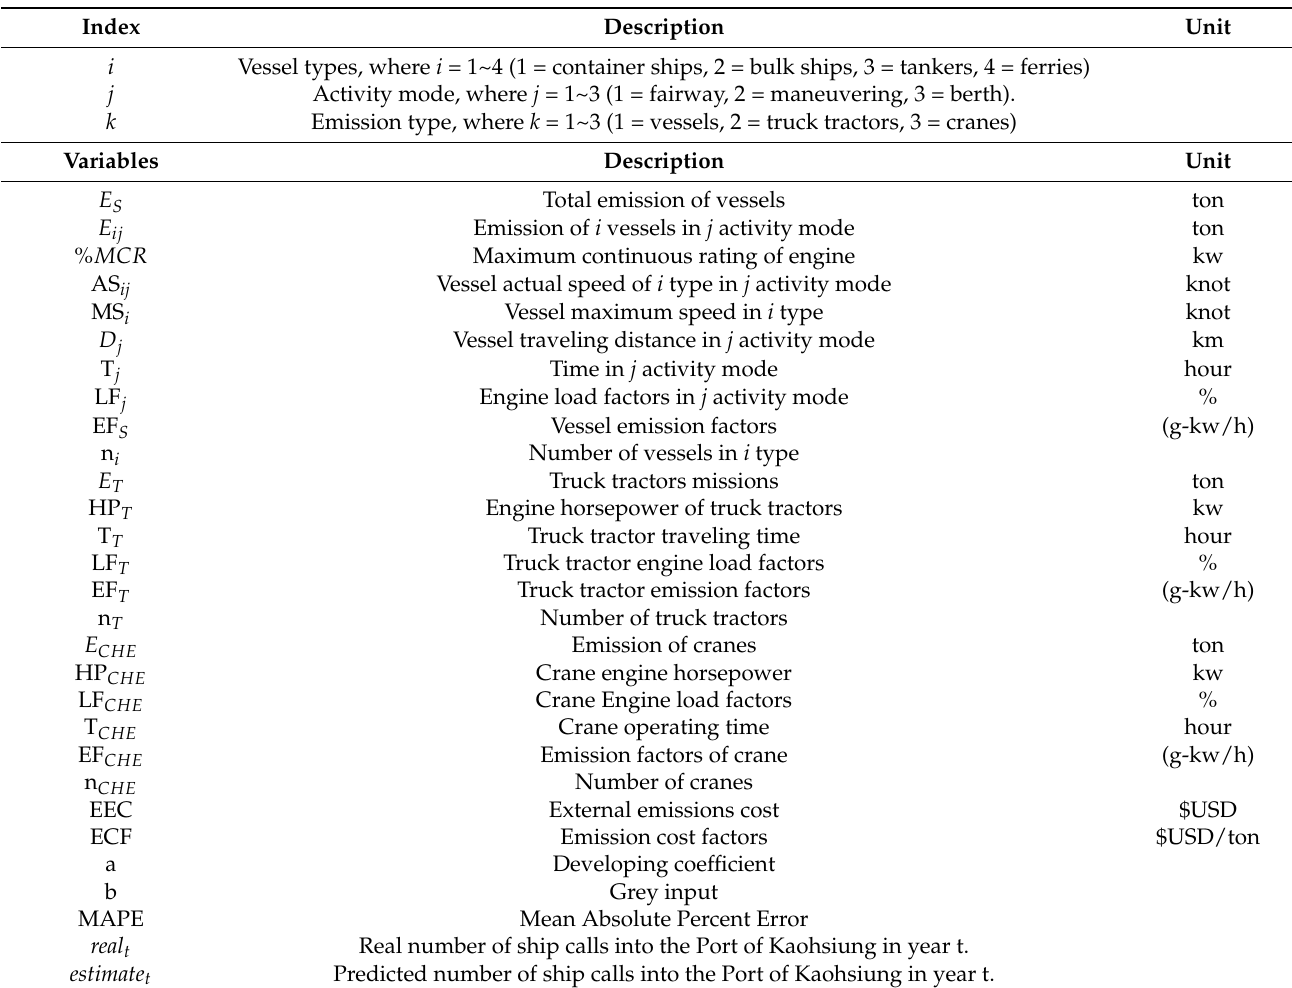
Table 2. Notations for parameters, variables and